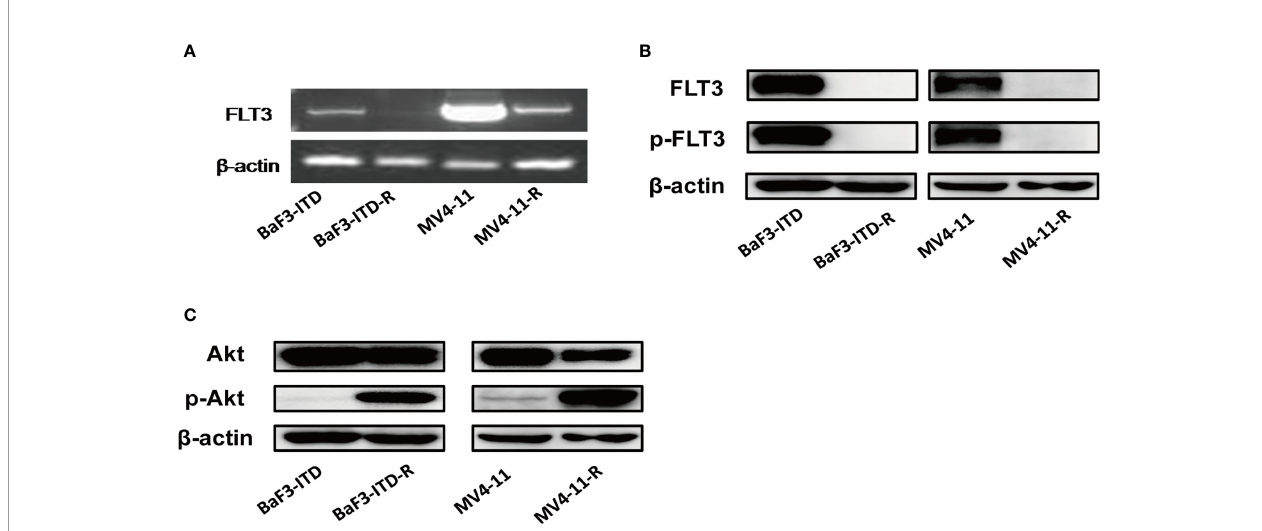
FIGURE 2 | FLT3 and PI3K/Akt signaling were detected. (A) PCR product of FLT3 gene was applied to agarose gel electrophoresis. b -actin was used as an internal control. (B, C) The protein level of total FLT3, phosphorylated-FLT3, total Akt, phosphorylated-Akt in BaF3-ITD, BaF3-ITD-R, MV4-11, MV4-11-R cells were evaluated by immunoblotting, with b -actin used as aloading